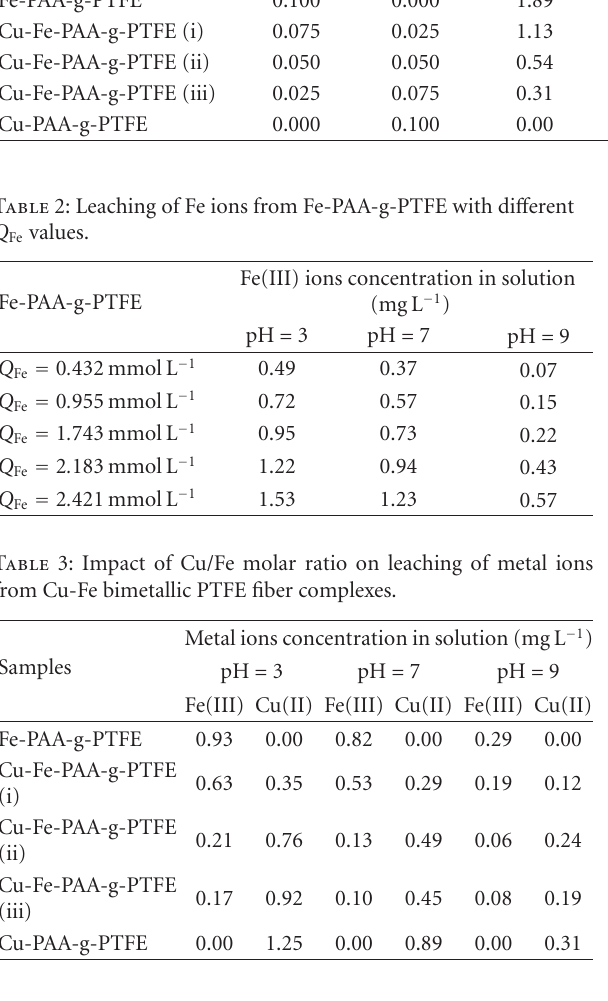
Table 1: E ff ect of Cu/Fe molar ratio of the catalysts on dye decomposition. Samples